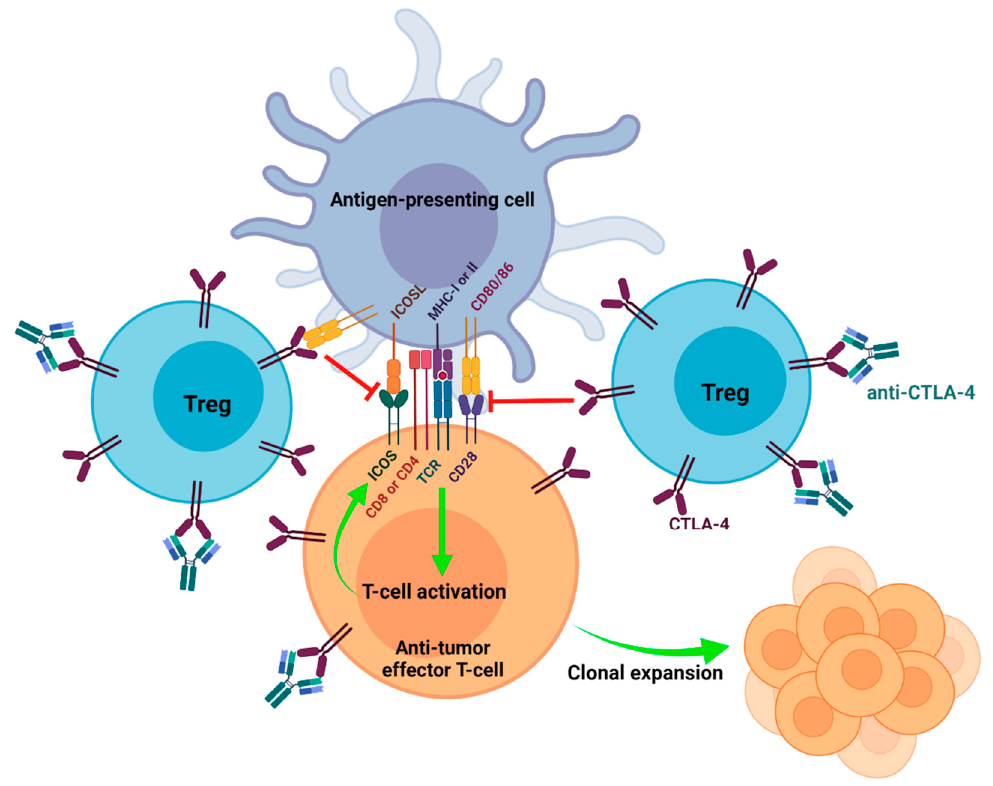
Figure 1. Enhancing the priming of effector T-cells by blockading CD80/86-CTLA-4 interactions. High expression of CTLA-4 on Tregs contributes to their immunosuppressive phenotype. Effector T-cells can express CTLA-4 transiently after T-cell activation. CTLA-4 engagement with CD80/86 on antigen-presenting cells inhibits CD28 costimulation that is required for T-cell activation and the upregulation of ICOS. Anti-CTLA-4 binds to CTLA-4 and inhibits CD80/86-CTLA-4 interactions to increase the activation of anti-tumor effector T-cells. T-cell activation results in clonal expansion and the employment of effector mechanisms that facilitate anti-tumor immune responses.